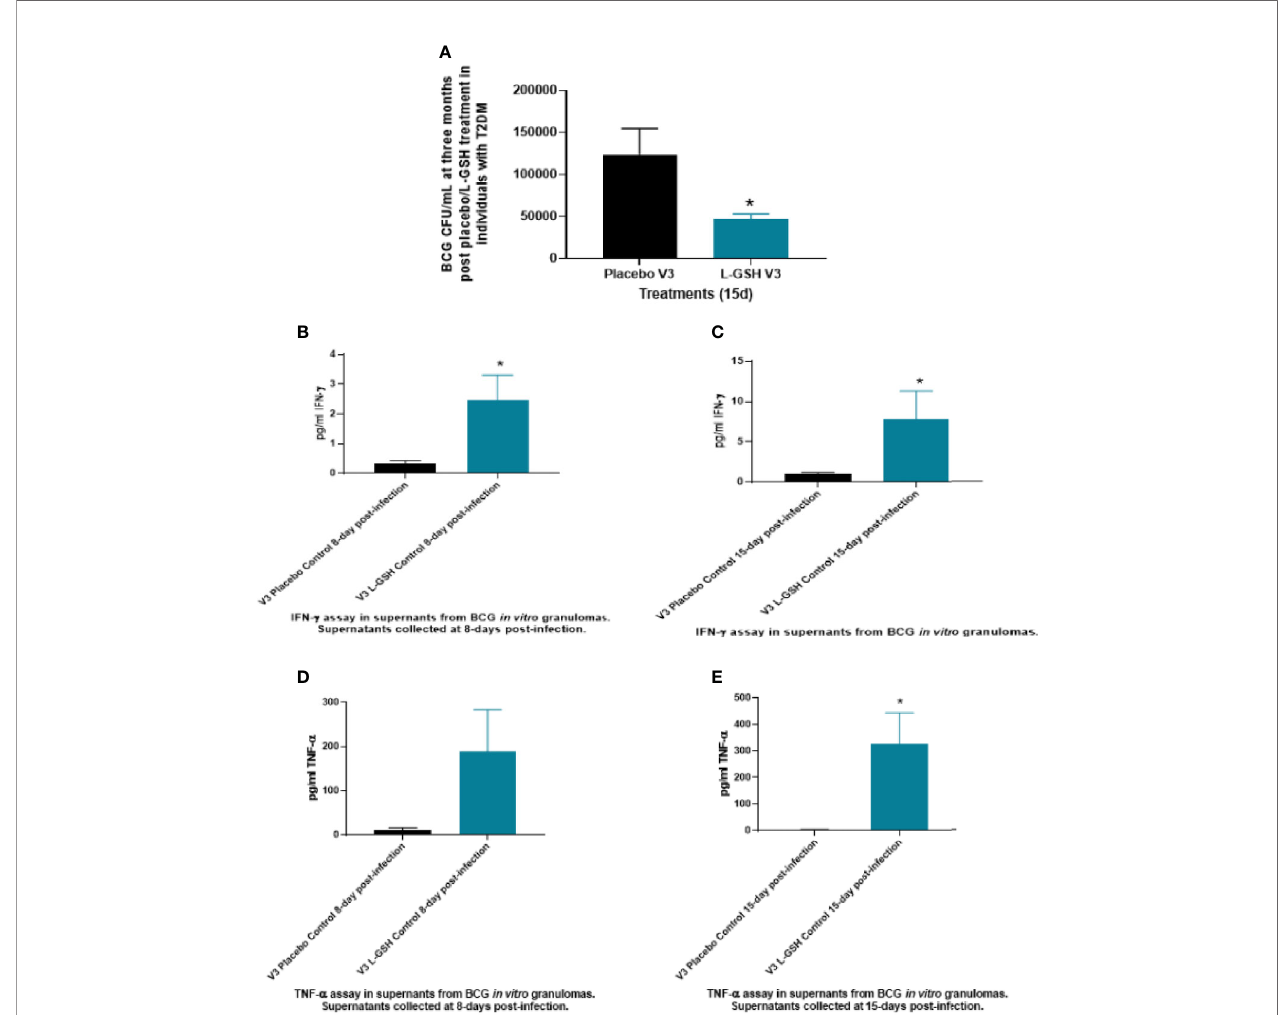
FIGURE 6 | Clinical trial fi ndings from in vivo and in vitro studies. Determination of BCG survival in the in vitro granulomas of T2DM subjects on L-GSH/or placebo supplement (A) . PBMCs isolated from individuals with type 2 diabetes at three months post- L-GSH/or placebo supplementation were infected in vitro with BCG and terminated at 15 days post-infection. The survival of BCG in the in vitro granulomas was determined by plating the granuloma lysates on 7H11. V3 represents in vitro granulomas generated from PBMCs isolated from subjects with T2DM at three months post- L-GSH/or placebo supplementation. Clinical trial fi ndings from in vivo and in vitro studies. Quanti fi cation of IFN- g in the in vitro granulomas of T2DM subjects on L-GSH/or placebo supplement (B, C) . PBMCs isolated from individuals with T2DM at pre- and post- L-GSH/or placebo supplementation were infected in vitro with BCG and terminated at 8- and 15-days post-infection. Levels of IFN- g in the granuloma supernatants harvested at 8 days (B) and 15 days (C) were determined by ELISA using an assay kit from Invitrogen. V3 represents in vitro granulomas generated from PBMCs isolated from subjects with T2DM at three months post- L-GSH/or placebo supplementation. No in vitro treatment is denoted as the control. Clinical trial fi ndings from in vivo and in vitro studies. Quanti fi cation of TNF- a in the in vitro granulomas of T2DM subjects on L-GSH/or placebo supplement (D, E) . PBMCs isolated from individuals with T2DM at pre- and post- L-GSH/or placebo supplementation were infected in vitro with BCG and terminated at 8 days and 15 days post-infection Levels of TNF- a in the granuloma supernatants harvested at 8 days (D) and 15 days (E) were determined by ELISA using an assay kit from Invitrogen. V3 represents in vitro granulomas generated from PBMCs isolated from subjects with T2DM at three months post- L-GSH/or placebo supplementation. No in vitro treatment is denoted as the control. A p <0.05 is considered signi fi cant indicated by an asterisk